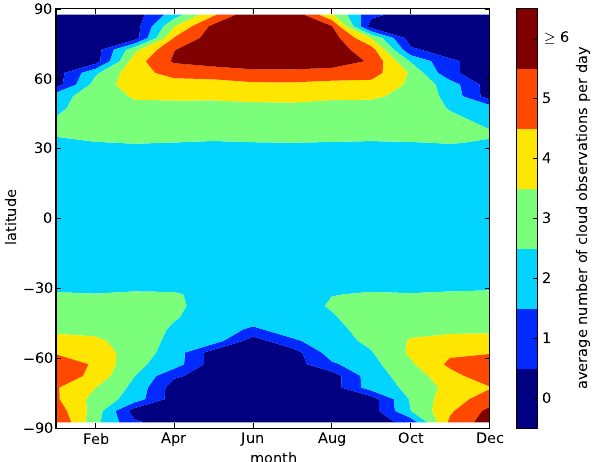
Figure 8. Intercomparison of the diurnal UV index extracted from the products (reprocessed with the algorithm version 1.20) and the corresponding ground-based SL-501 measurements (GB) in Sodankylä (67.37 ◦ N, 26.63 ◦ E), Finland, on selected days in June 2007 when Metop-A (M-A) and NOAA-18 (N-18) were used for sampling of the cloud optical depth. Vertical lines mark the times of the satellite overpasses used. The consecutive overpasses are roughly 100min apart and vary slightly during the orbit repeat cycle for both satellites. As a result, the overpasses from the two satellites can be very close to each other in time. The apparent miss- ing overpasses are due to the quality control of the cloud optical depth observations (Sects. 4.2.1 and 4.2.3).